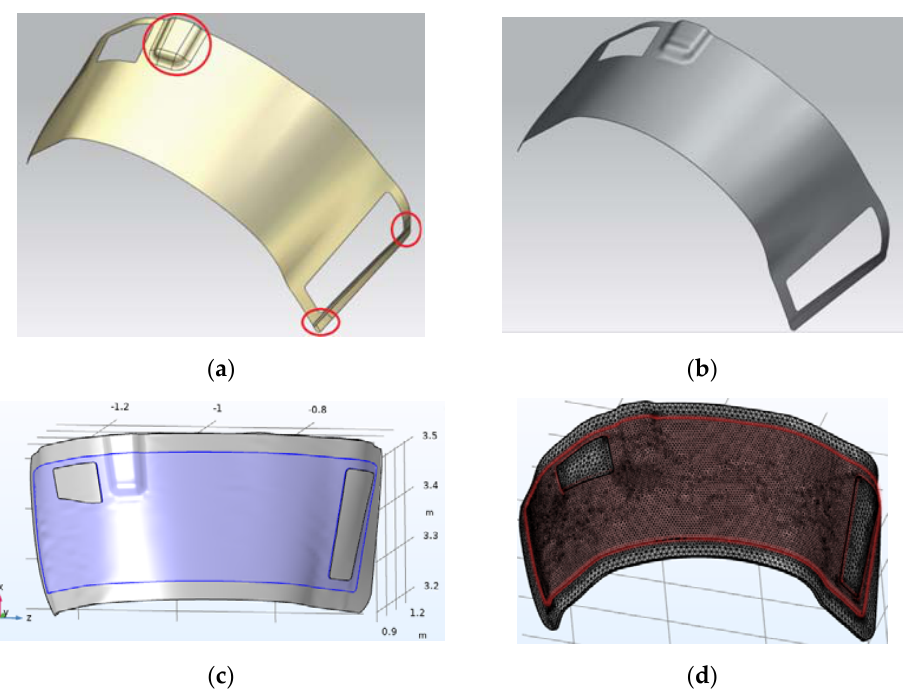
Figure 1. From the CAD model of the molded composite structure to the finite element (FE) model of the system of its vacuum infusion: ( a ) The initial CAD model; ( b ) CAD model of the structure after correction of its surface topology; ( c ) CAD model of assembled open mold with preform laid on it; ( d ) CAE model of the assembly after FE